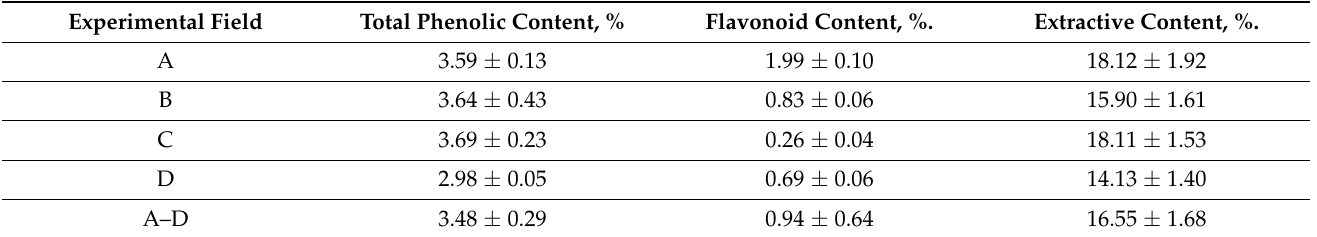
Table 2. Concentrations of bioactive compounds in the dry matter of O. vulgare (means ± SE). Experimental Field Total Phenolic Content, % Flavonoid Content, %. Extractive Content,